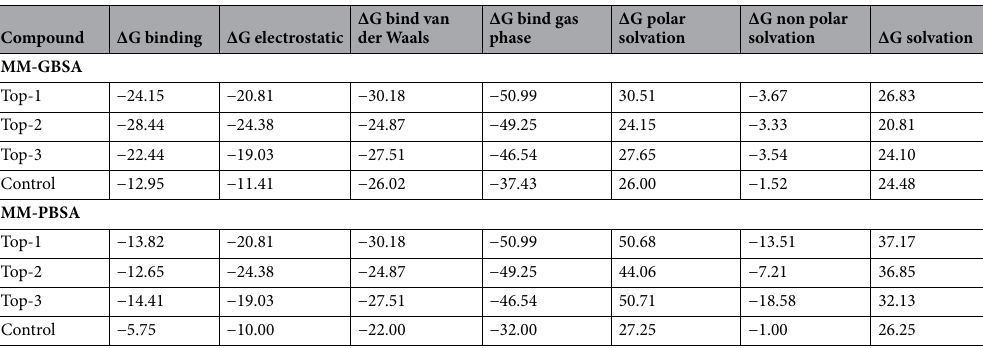
Table 1. MM-GBSA and MM-PBSA net binding energy of the compounds/control presented for each energy component.